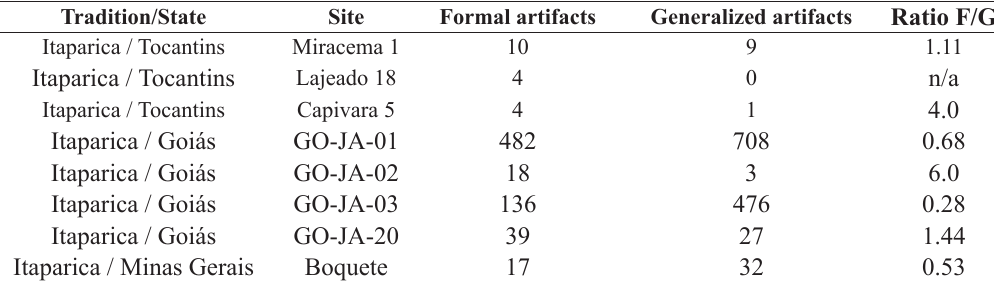
Ratios of formal to generalized (F/G) artifacts for some Itaparica sites (from Bueno 2005, Fogaça 2001, Schmitz et al. 1996,